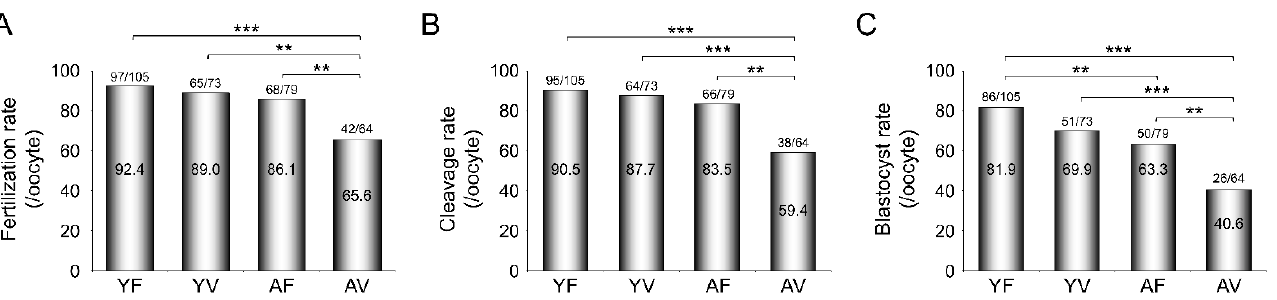
Figure 5. Effects of vitrification on the development of embryos from in vitro fertilization of oocytes from young and aged mice. ( A – C ) The rates of fertilization, cleavage, and blastocyst formation of oocytes from young ( n = 10 mice, 1- to 2-month-old) and aged ( n = 30 mice, 10- to 12-month-old) mice ( n = 64–105 oocytes in each group) after in vitro fertilization. Statistical comparisons were performed using chi-squared test. ** p < 0.01, *** p < 0.005. YF: Young fresh, YV: Young vitrified, AF: Aged fresh, AV: Aged vitrified.